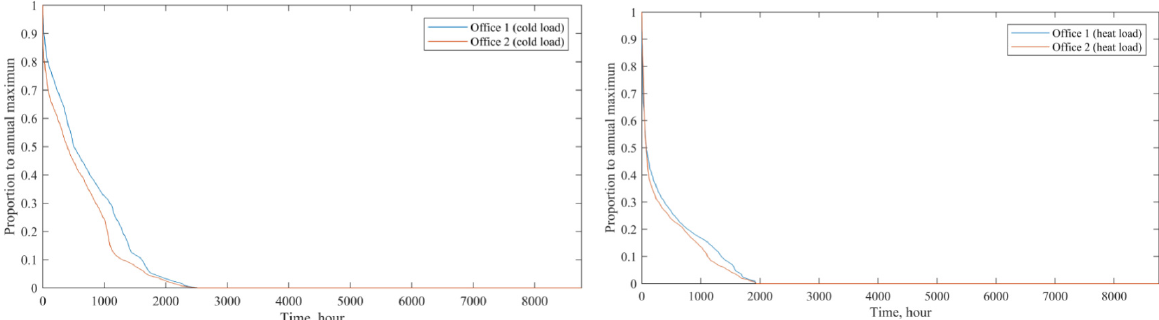
Figure A3. Annual 8760 load change curve of office buildings.